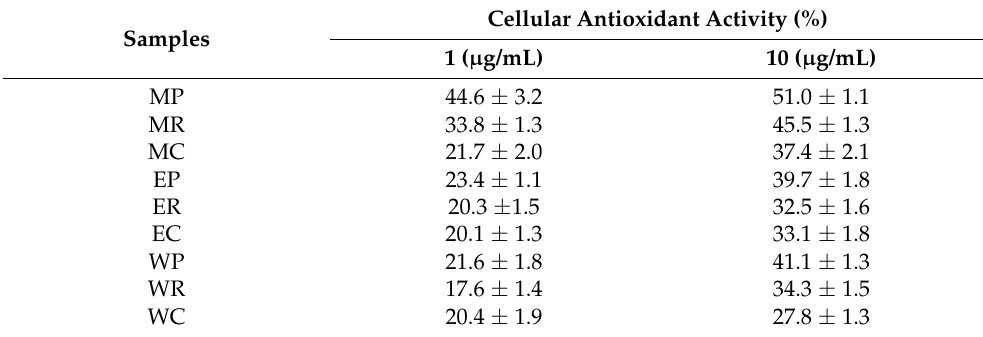
Table 2. Cellular antioxidant activity (%) of Argylia radiata extracts is determined at different concentrations.